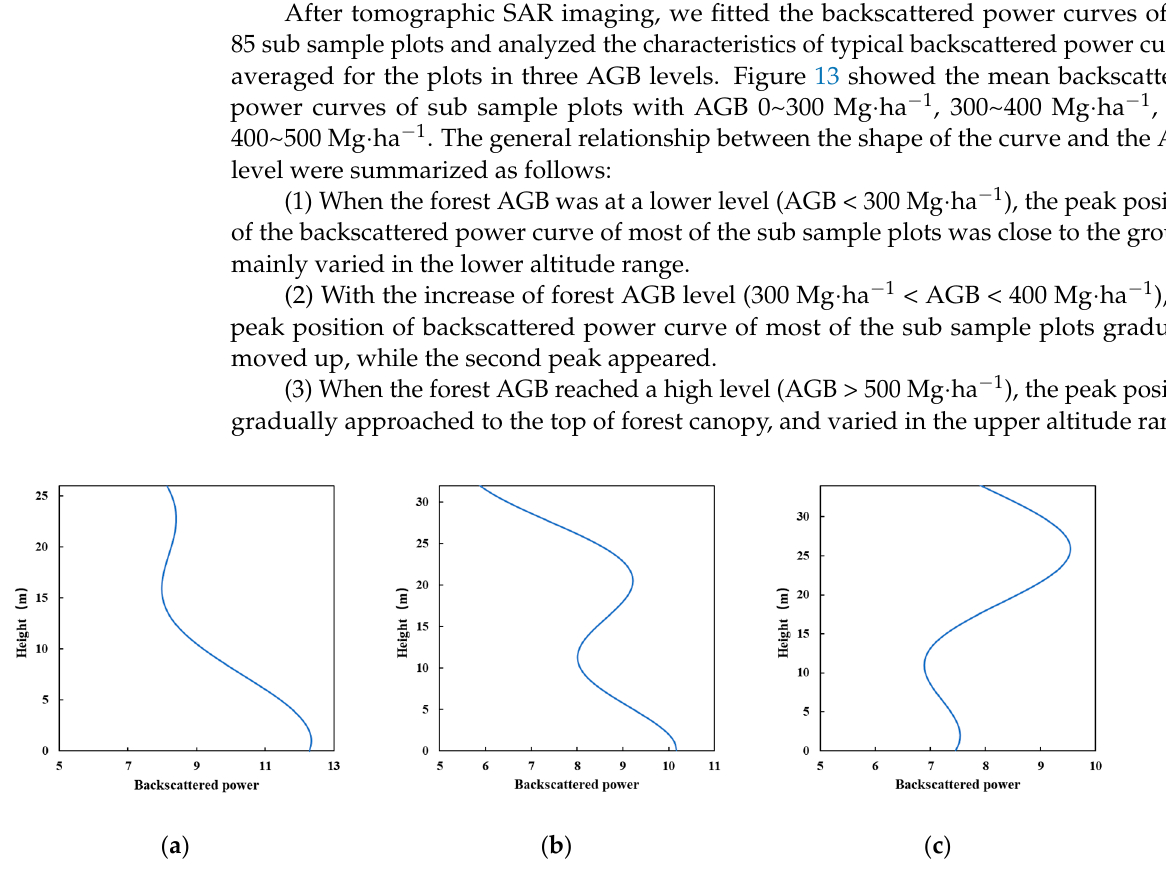
Figure 13. Typical backscattered power curve of sub sample plots with different biomass level. ( a ) Biomass level: 0~300 Mg ∙ ha − 1 ; ( b ) biomass level: 300~400 Mg ∙ ha − 1 ; ( c ) biomass level: 400~500 Mg ∙ ha − 1 .